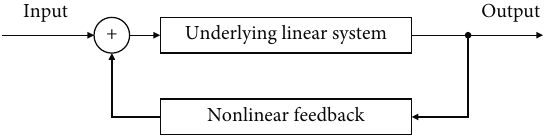
Figure 2: Feedback interpretation of nonlinear vibrating systems.